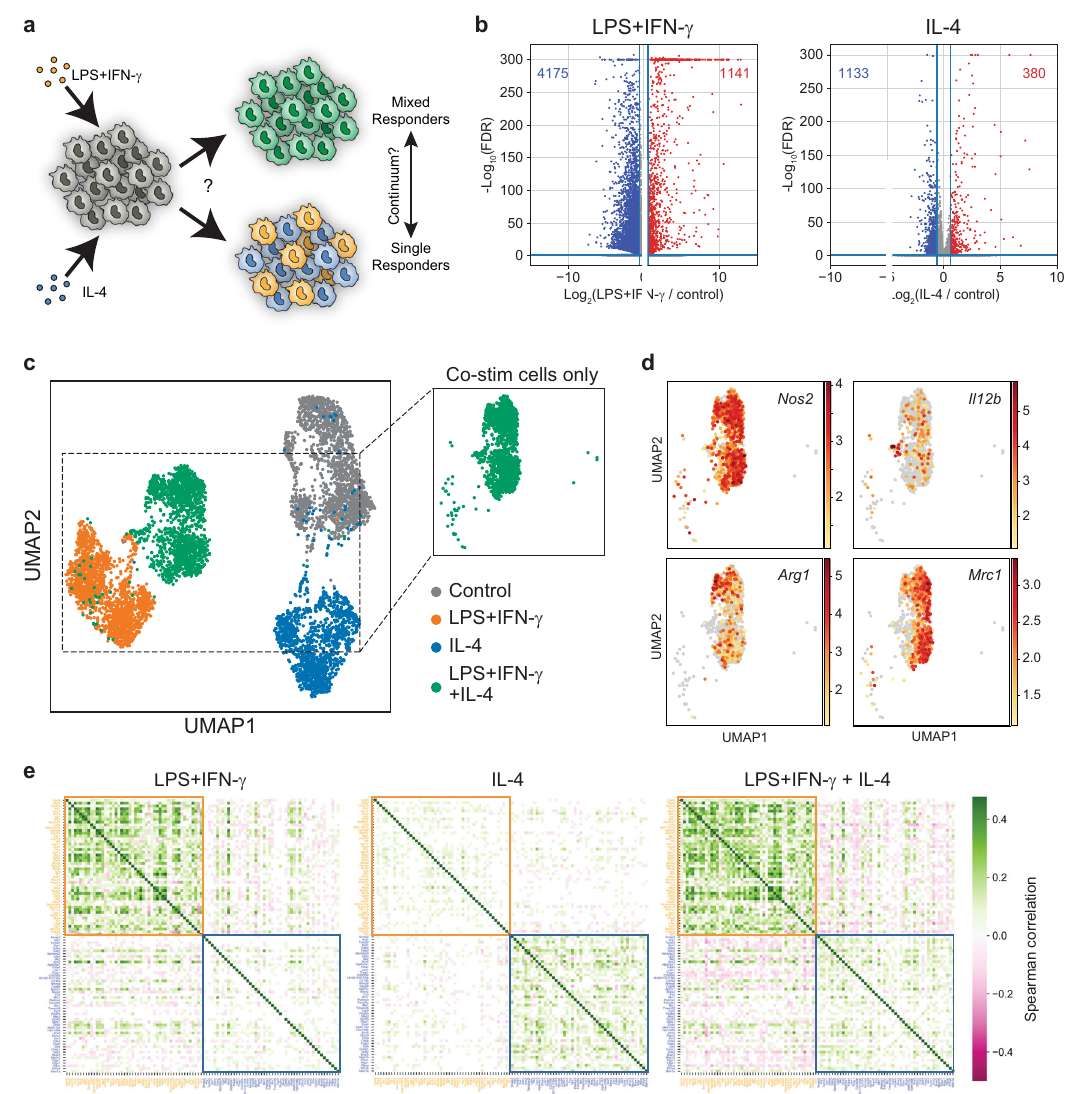
Fig. 1 Co-stimulation induces a global mixed gene expression program across individual macrophages. a Schematic depicting how co-stimulation could lead to either mixed responses or specialized responses in individual macrophages. b Volcano plot of differential gene expression after stimulation for 6 h with 10 ng/ml LPS + 10 ng/ml IFN- γ (left) or 100 ng/ml IL-4 (right) relative to control. Genes signi fi cantly upregulated (red) and downregulated (blue)